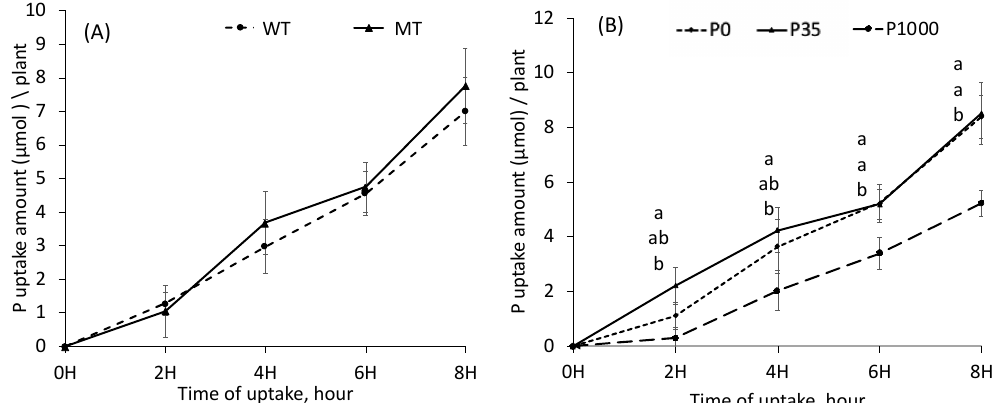
Figure 1. Phosphorus (P) uptake dynamics in two barley genotypes. ( A ) Comparison of average P uptake of two genotypes, ( B ) Comparison of average P uptake under three P levels in the nutrient solution: (1000 (P1000), 35 (P35) or 0 (P0) µ M NaH 2 PO 4 ). Di ff erent lower-case letters indicate statistically significant di ff erence ( p < 0.05) among three P concentrations. Measurements were made continuously for eight hours. The solution was sampled every two hours to determine the remaining P concentration in the nutrient solution. The bars represent the standard errors of four replicates. WT stands for wild type, and MT for root hairless brb mutant.